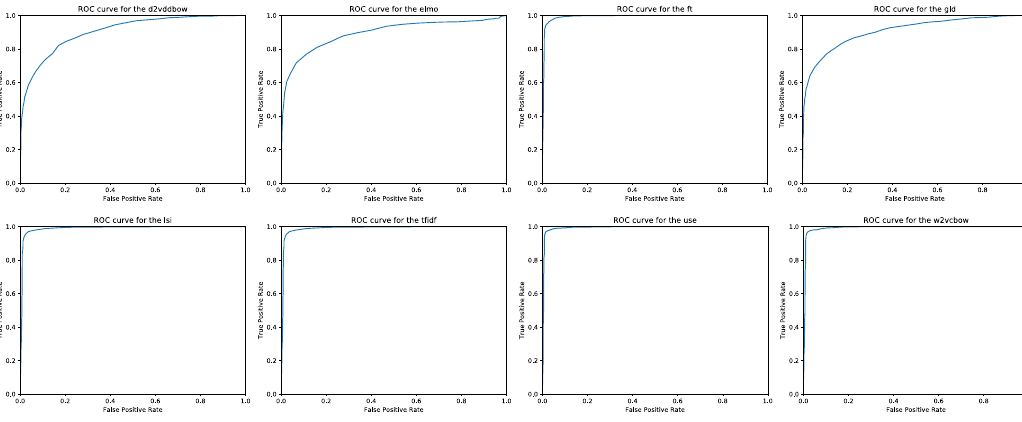
Figure A2. Receiver operator characteristic curves for eight models processing C&S corpus.